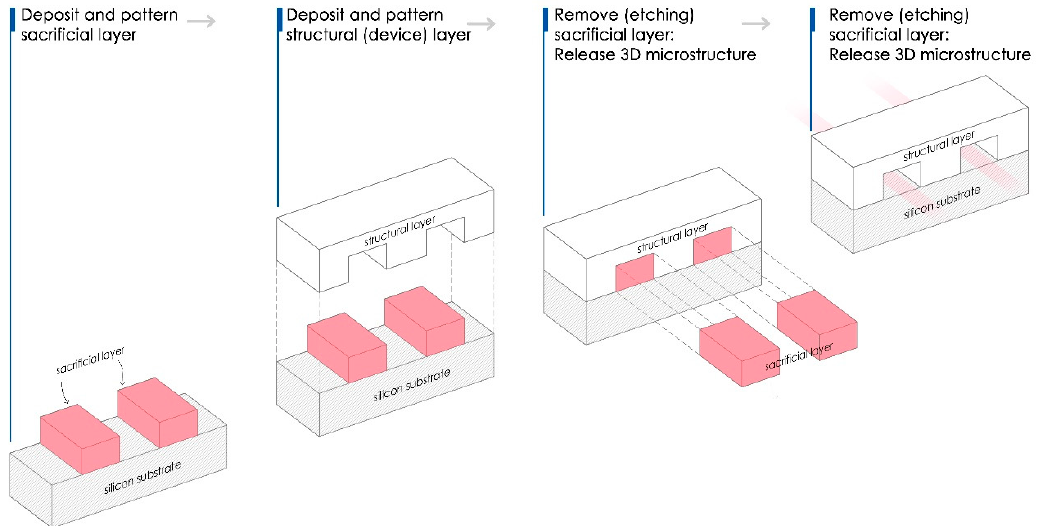
Figure 3. Simplified scheme of a lithography process.